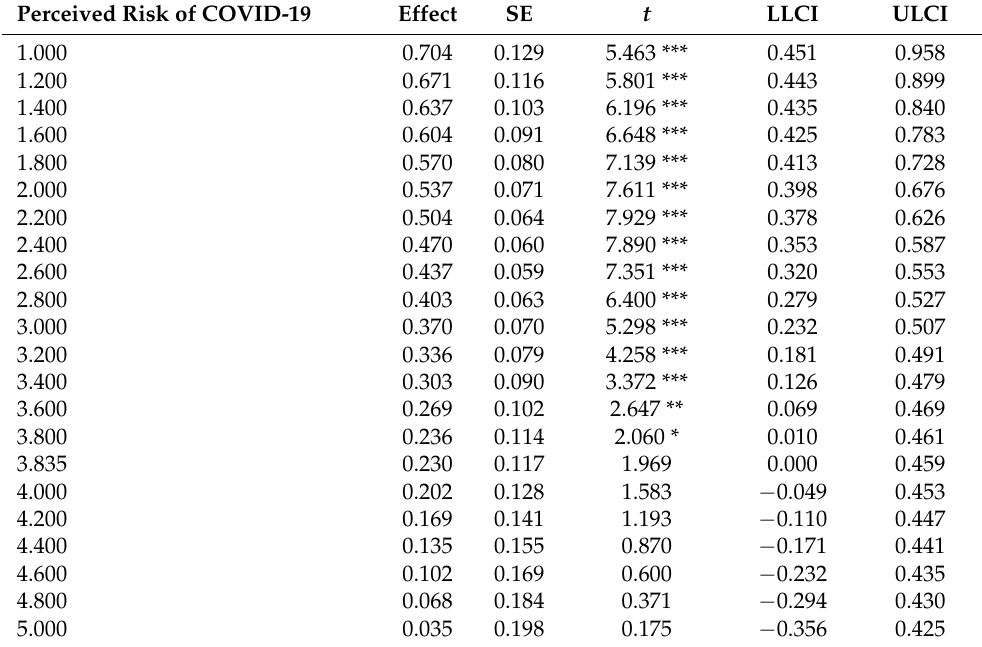
Table 8. COVID-19 perceived risk value defining Johnson-Neyman significance region.